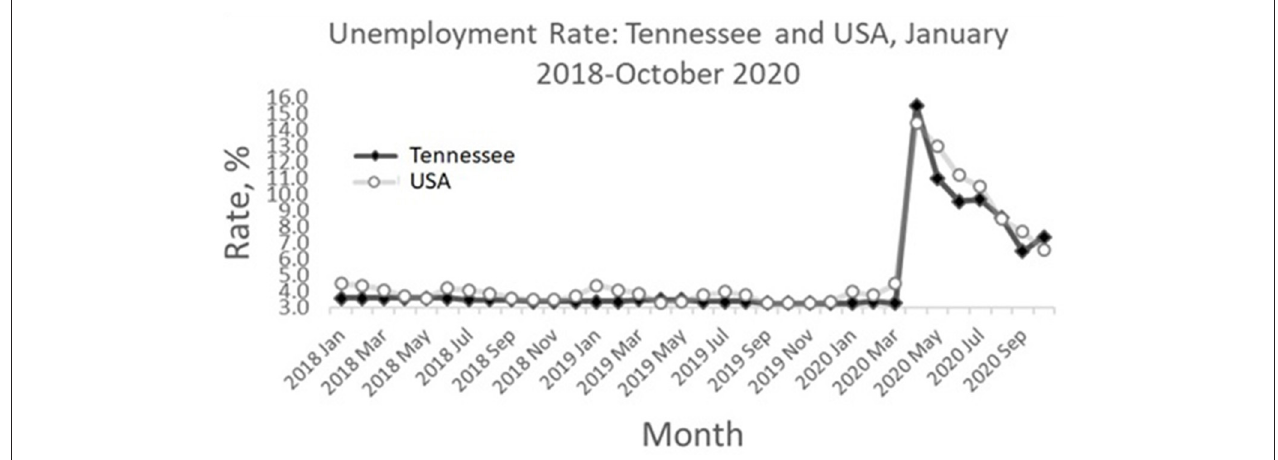
FIGURE 1 | Unemployment rate for workers 16 years and over, January 2018–October 2020, % (seasonally adjusted headline number published each month).